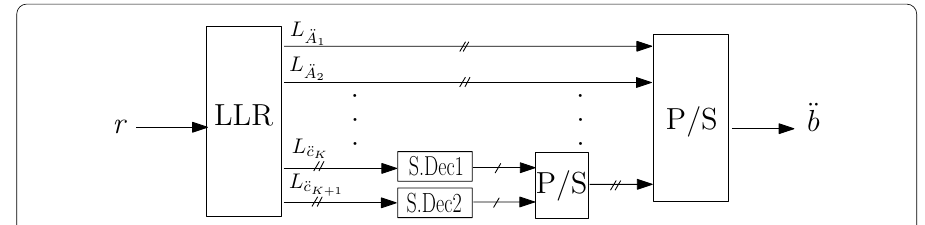
Fig. 7 Shaping technique block at the receiver